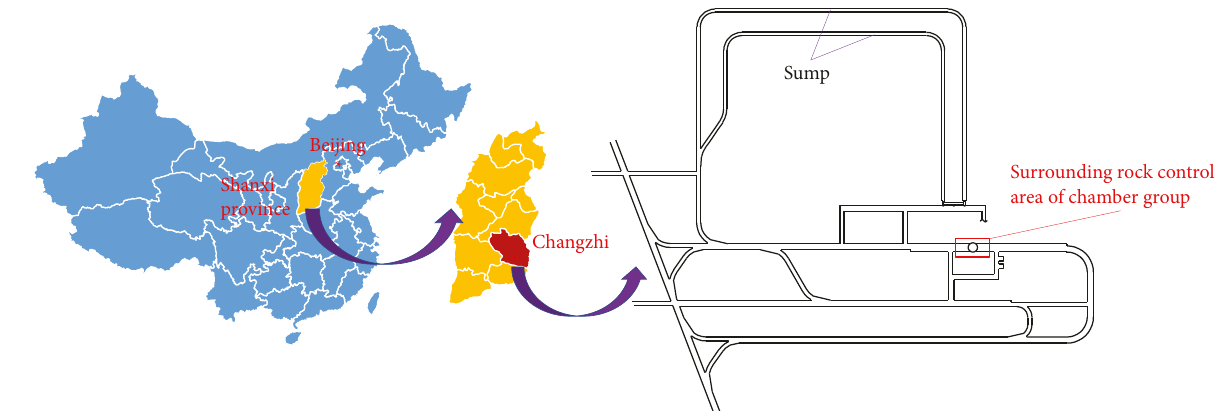
Figure 1: Schematic diagram of mine